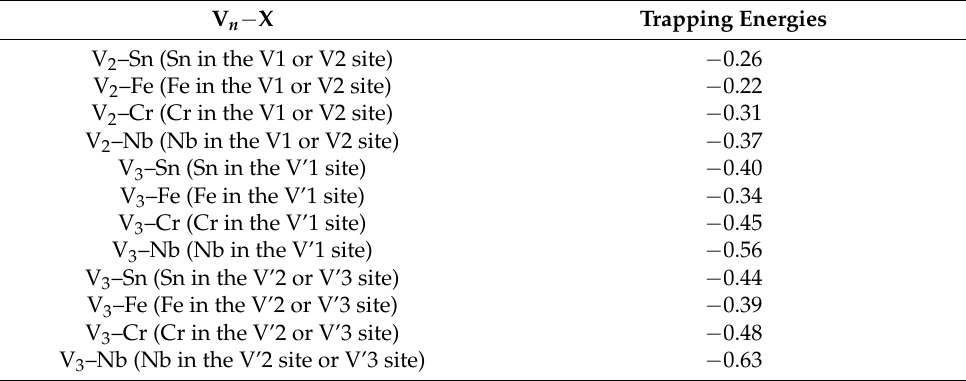
Table 1. The trapping energies for V n –X (in eV); here n = 2 or